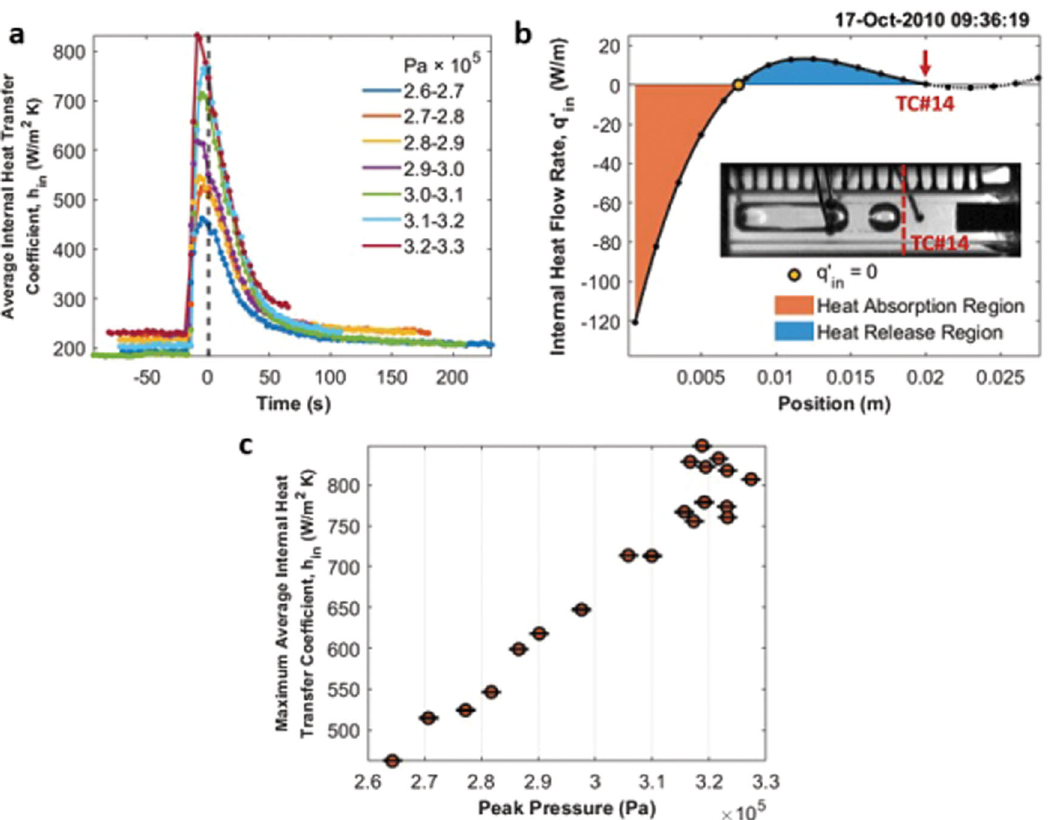
Fig. 8 Average internal heat transfer coef fi cient, h in , and q ’ in pro fi le at the nucleation stage. a Change of the average internal heat transfer coef fi cient with time in the heat absorption region for the 7 peak pressure groups. The maximum error of the average heat transfer coef fi cients for the 7 cycles in ( a ) is 1.34 W/m 2 K. b Internal heat fl ow rate pro fi le, q ’ in , at the moment of nucleation, Fig. 3b, in the cycle. c The maximum average internal heat transfer coef fi cients for the entire 20 nucleation events in the analysis. Errors are smaller than 0.58 W/m 2